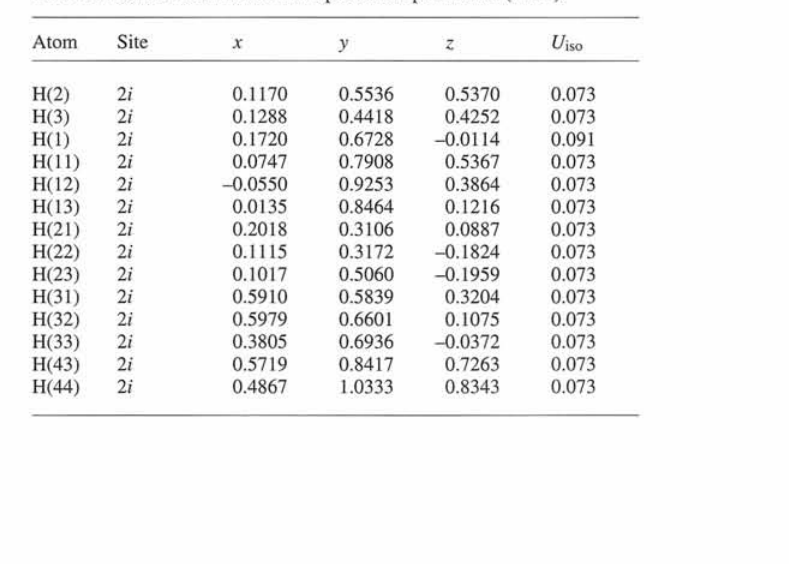
Table 2. Atomic coordinates and displacement parameters (in Á 2